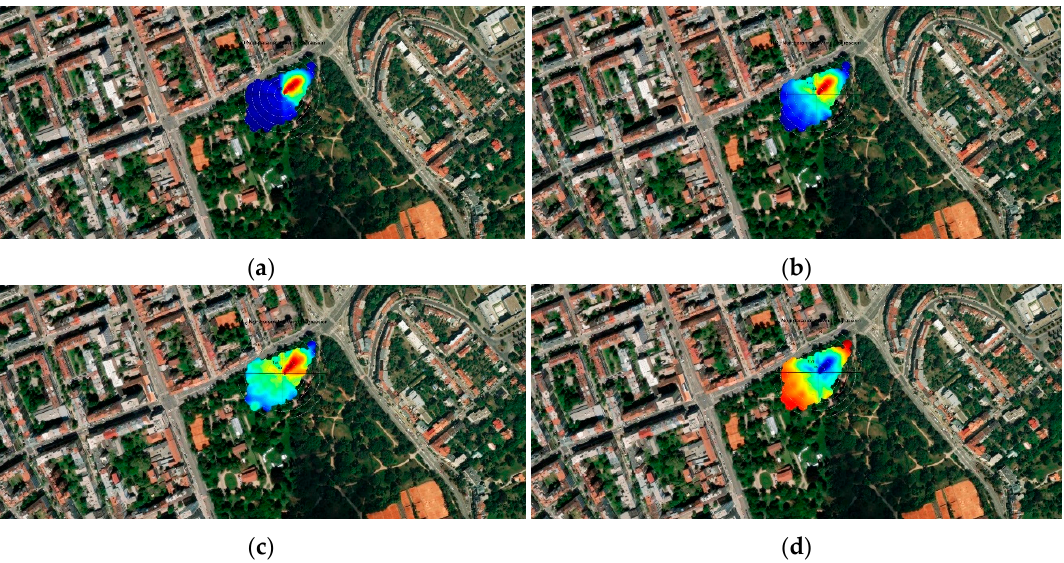
Figure 15. The NO ( a ), NO 2 ( b ), PM 10 ( c ), and O 3 ( d ) concentration relationships to the wind speed and direction at Lužánky SS; sampling started on 6.3.2019 7:00.